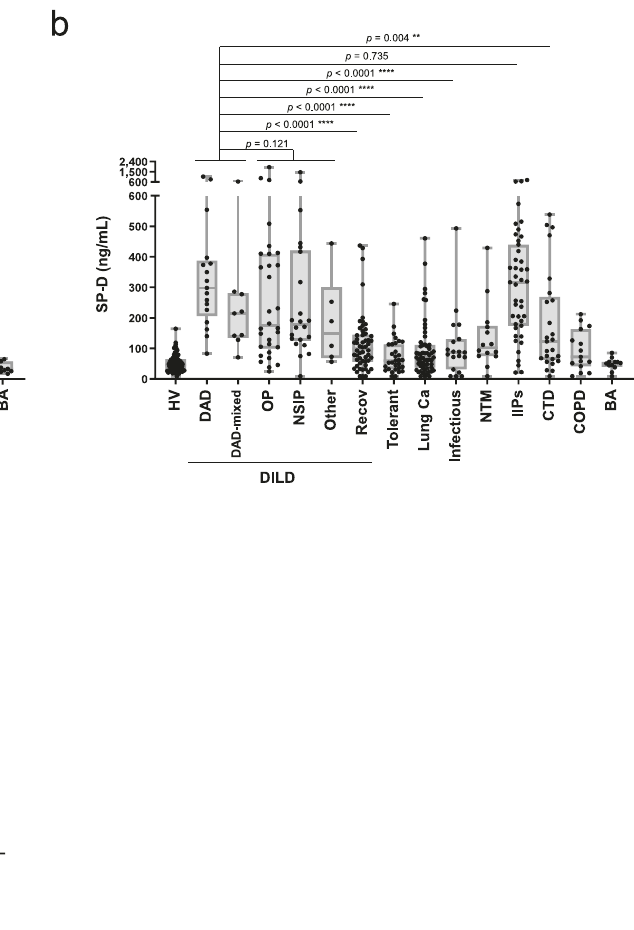
*** p <0.001; **** p <0.0001. HV healthy volunteers, DAD diffuse alveolar damage, OP organizing pneumonia, NSIP nonspeci fi c interstitial pneumonia, Recov all DILD patients in recovery, Tolerant tolerant control, Lung Ca lung cancer, IIPs idiopathic interstitial pneumonias, CTD lung disease associated with connective tissue disease, COPD chronic obstructive pulmonary disease, NTM nontuberculous mycobacteria, BA bronchial asthma, Infectious bacterial and mycotic pneumonia. Corresponding median (range) values for each group are shown in Supplementary Table 8. Source data are provided as a Source data fi